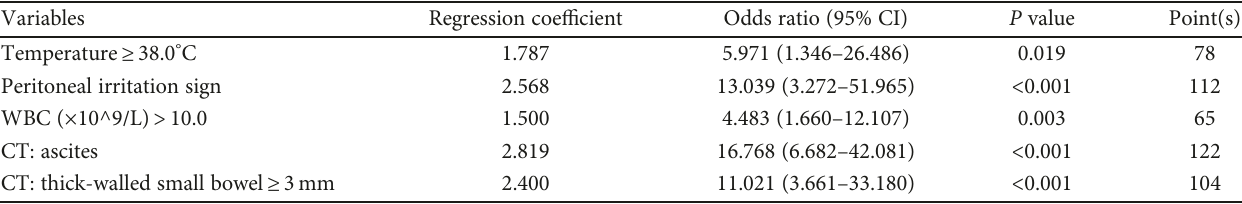
Table 4: Multivariate associations in patients with strangulated small bowel obstruction (SSBO) and development of the new prediction model for SSBO.